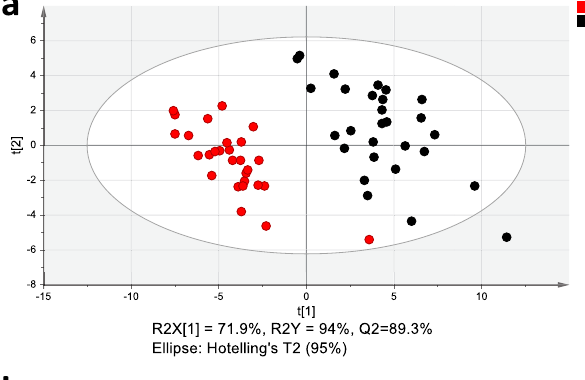
Fig. 5 Tumor and peri-tumoral tissues have distinct metabolic states as revealed by LC-MS analysis. a , b Partial least square-discriminant analysis (PLS-DA) score plot from LC-MS data for aqueous metabolites, analyzed by : a C18pfp-based method ( R 2 X = 71.9%, R 2 Y = 94% and Q 2 = 89.3%) ( a ); and a behamide-based method ( R 2 X = 55.8%, R 2 Y = 80.1% and Q 2 = 74.7%) ( b ). In both cases, at least seven independent biological replicates of colon tissue from peri-tumorous (red) and tumorous (black) tissues were included. c , d Plots showing the individual metabolites driving the separation among the tissue types (loadings), for the C18pfp-based method ( c ) and the behamide-based method ( d ), with the variables (i.e., metabolites) represented in green circles, while the center for each genotype (peri-tumorous-DA(1), tumorous-DA(2)) is